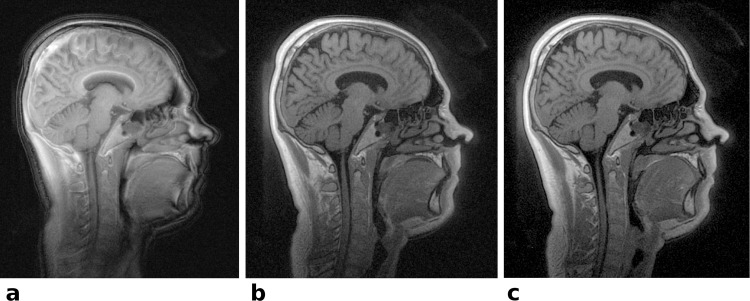
In vivo head images–the effect of delay correction: Central sagittal slices of a volunteer’s head.(a) The reconstructed image of the single echo sequence without delay correction exhibits severe signal shifts compared to the images corrected with the system delay obtained from the template scan (b). Note the large signal voids in the uncorrected image (a), especially at the outer edges, like the chin and the face area. The same slice acquired with the dual echo reference sequence and with delay correction is shown in (c). The spoiling regime applied to the single echo sequence does not cause any visible artifacts (b) compared to the dual echo sequence with constant spoiler moments (c).